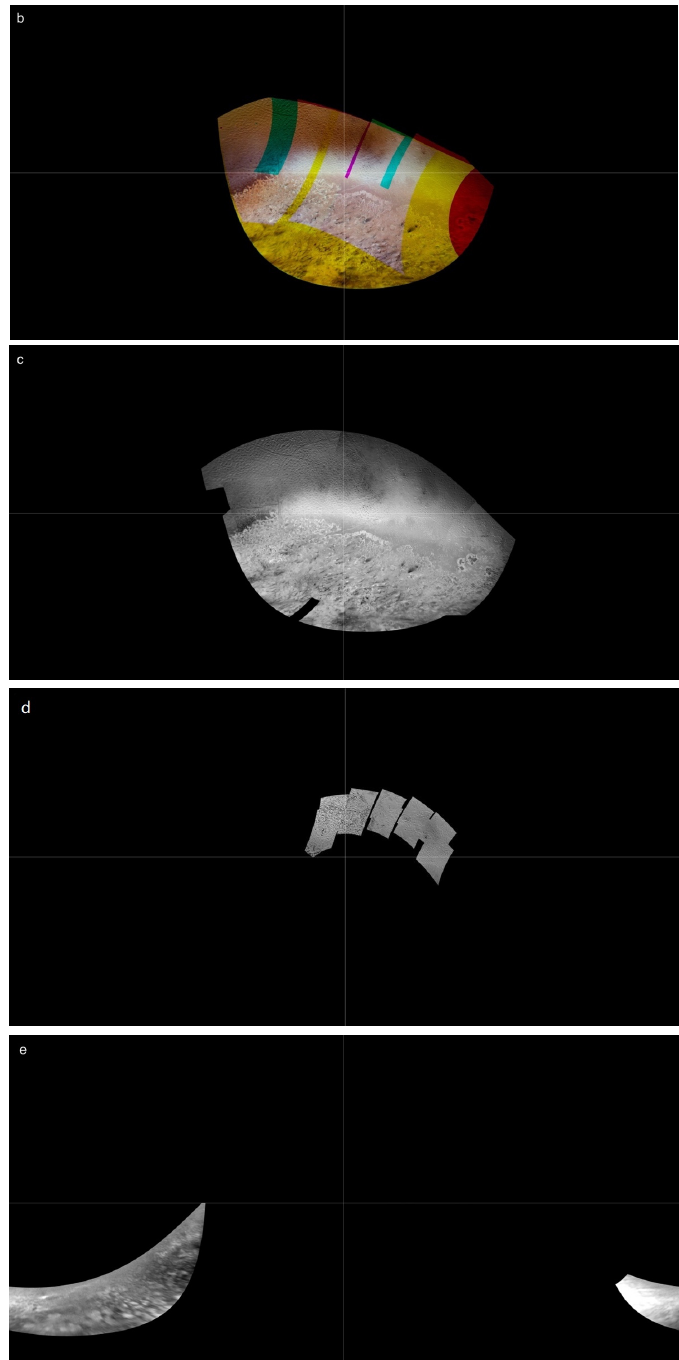
Figure 2. ( a ) Five color mapping mosaic of Triton at 4 km pixel scales and ~40 ◦ phase angles. This color composite shows the green, violet, and UV filter images as red, green and blue colors. Image ID c1138639.imq through c1138715.img. ( b ) Partial three-color mapping mosaic of Triton at 1.6 to 1.4 km pixel scales and ~61 ◦ phase angles. This color composite shows the green, violet, and UV filter images as red, green and blue colors. Image ID c1139255.imq through c1139323.img. ( c ) Mapping mosaic of Triton in clear filter at 1.0 to 0.6 km pixel scales and 63–79 ◦ phase angles. Image ID c1139340.imq to c1139533.img. ( d ) Partial mapping mosaic of Triton in clear filters at 0.42 to 0.34 km pixel scales and 98–116 ◦ phase angles. Image ID c1139607.imq to c1139629.imq. ( e ) High phase angle image of Triton at 2–4 km pixel scales and ~135 ◦ phase angles. Image ID c1140959.imq, c1140138.imq and